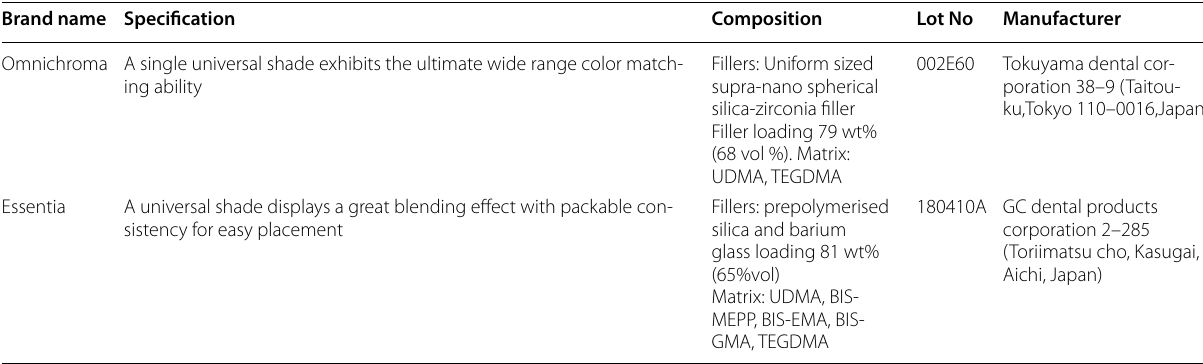
Table 1 Materials used, specification, composition, lot number and